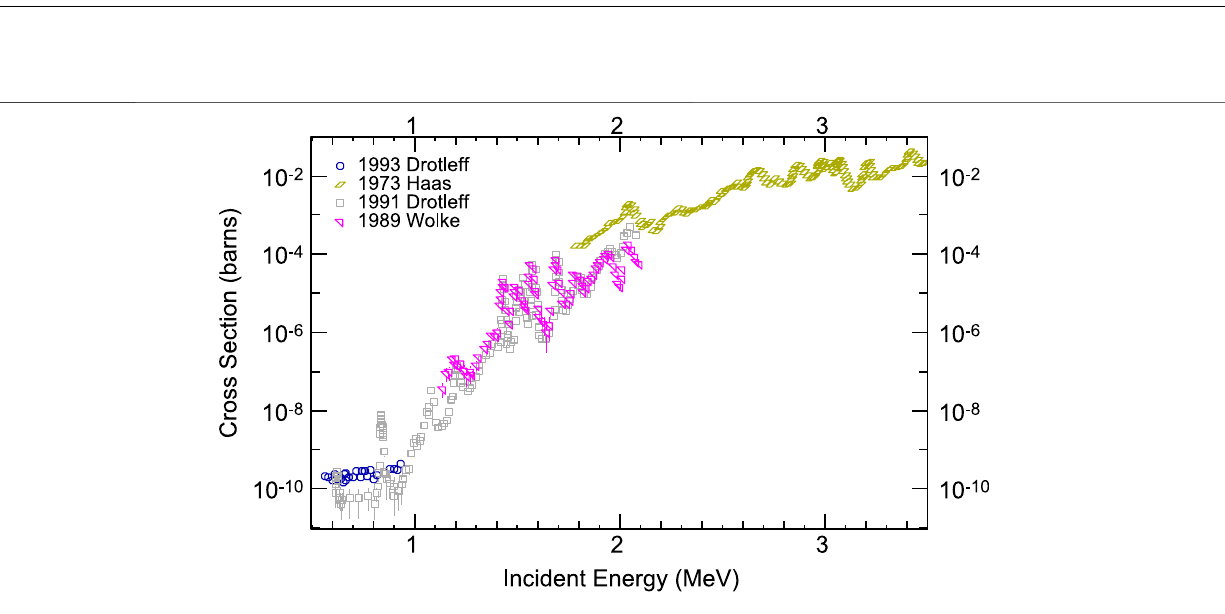
Frontiers in Astronomy and Space Sciences |